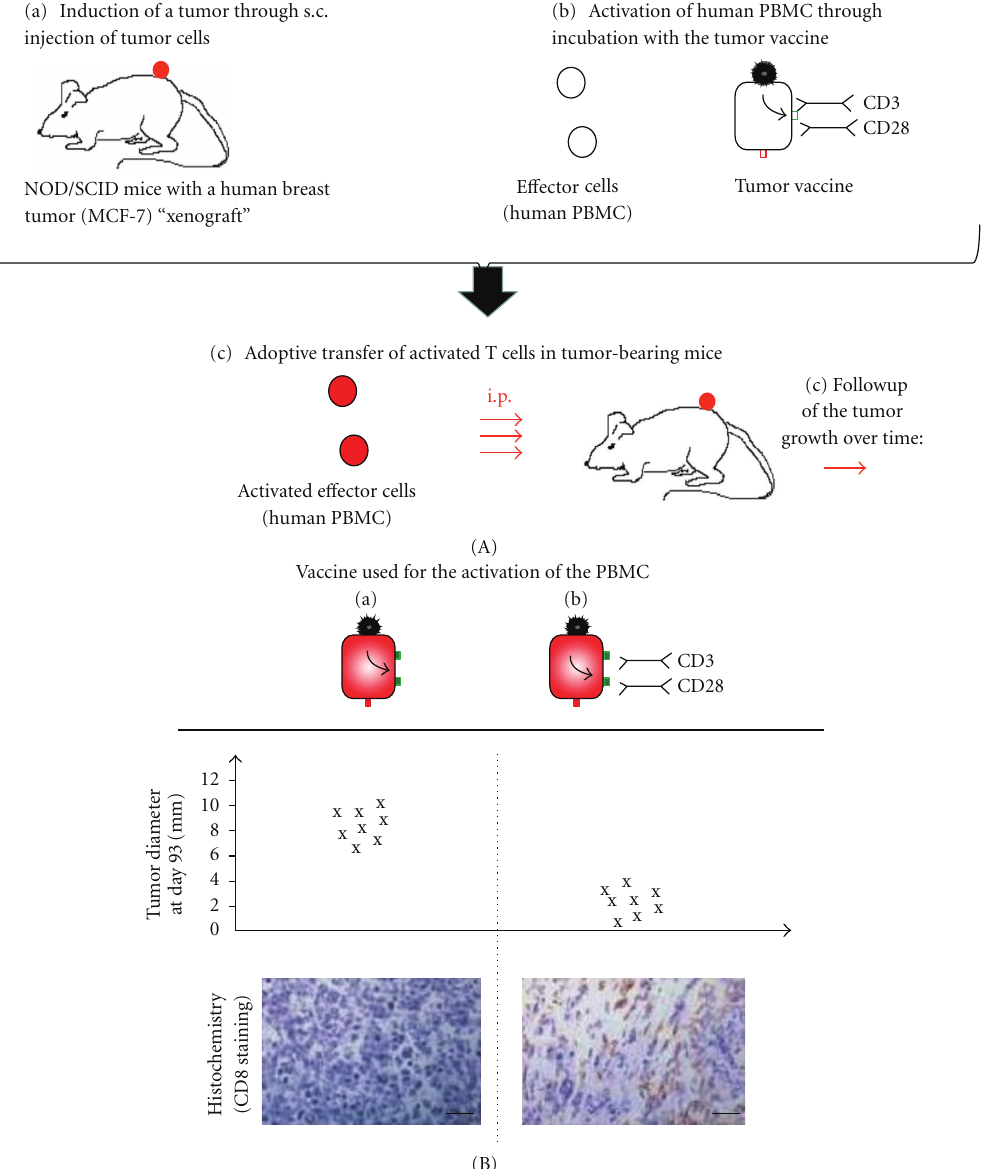
Figure 4: In vivo antitumor activities of human PBMC preactivated in vitro by the NDV-based tumor vaccine of the second generation. (A) Experimental protocol. MCF-7 tumor cells were injected subcutaneously into NOD/SCID mice ( n = 8 per group). The mice were kept until palpable tumors were established (6–8mm in diameter) (a). Then, at days 1, 4, and 7, the mice were treated by i.p. injection of 10 7 PBMC which were preactivated ex vivo for 3 days by the NDV-based tumor vaccine of the first or second generation obtained using the MCF-7 cell line (b). Tumor growth was then monitored over time (c). (B) Tumor diameter and representative immunohistochemistry images of tumor tissue sections. Tumor-bearing mice were treated with PBMC activated with MCF7-NDV (left) or with PBMC preactivated with MCF-7- NDV loaded with bsHN-CD3 and bsHN-CD28 (right) and were analyzed over time for tumor growth, and data at day 93 is represented (top). At this time point, some mice were sacrificed, and the tumor sections were stained with mAbs against the human CD8 antigen and analyzed by fluorescence microscopy (bottom). Scale bar, 100 μ m (adapted from [42]).